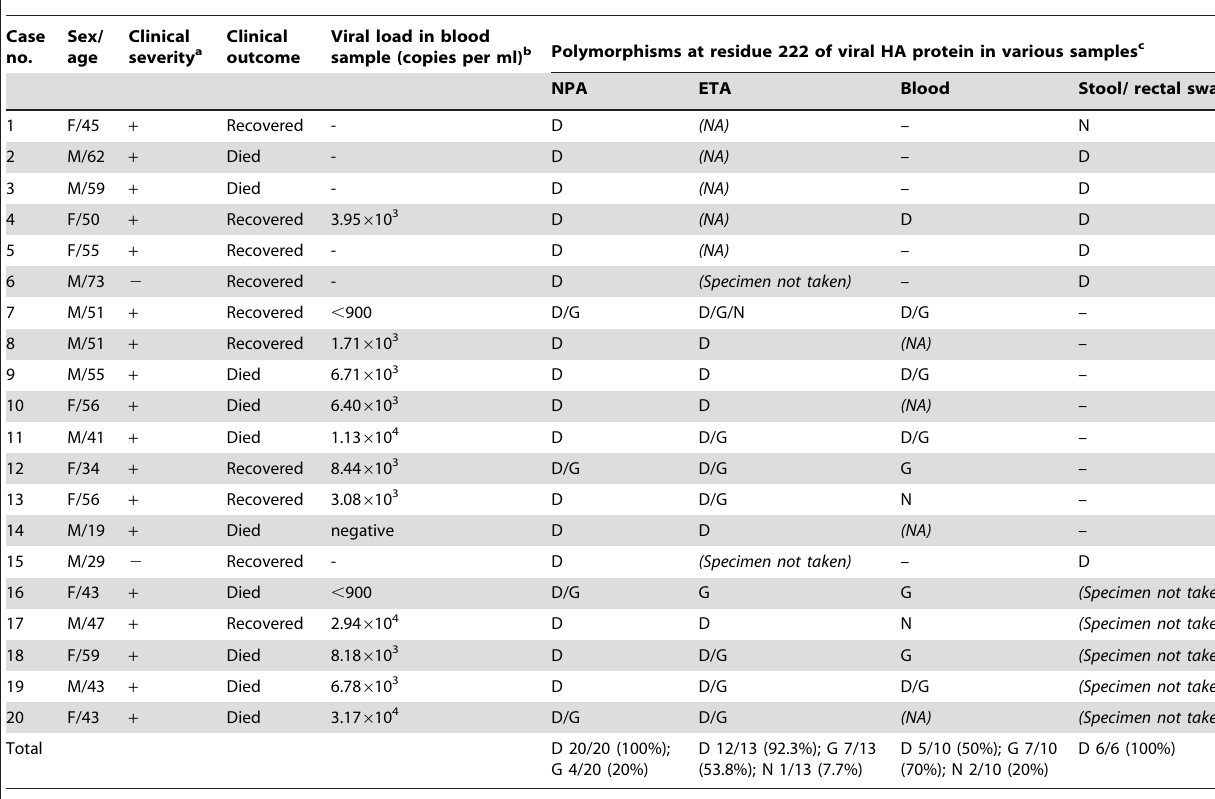
Table 2. Viral hemagglutinin (HA) polymorphisms in specimens of patients with positive detection of pandemic influenza A/H1N1/ 2009 viral RNA outside the respiratory system.